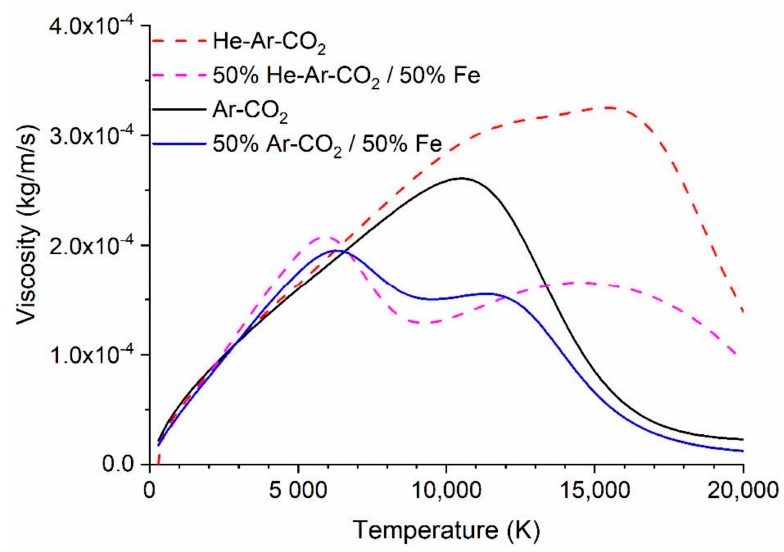
Figure 16. Viscosity for the ternary and binary blends and for 50 mol% mixtures of each blend with metal vapor, as a function of temperatures [19–21].